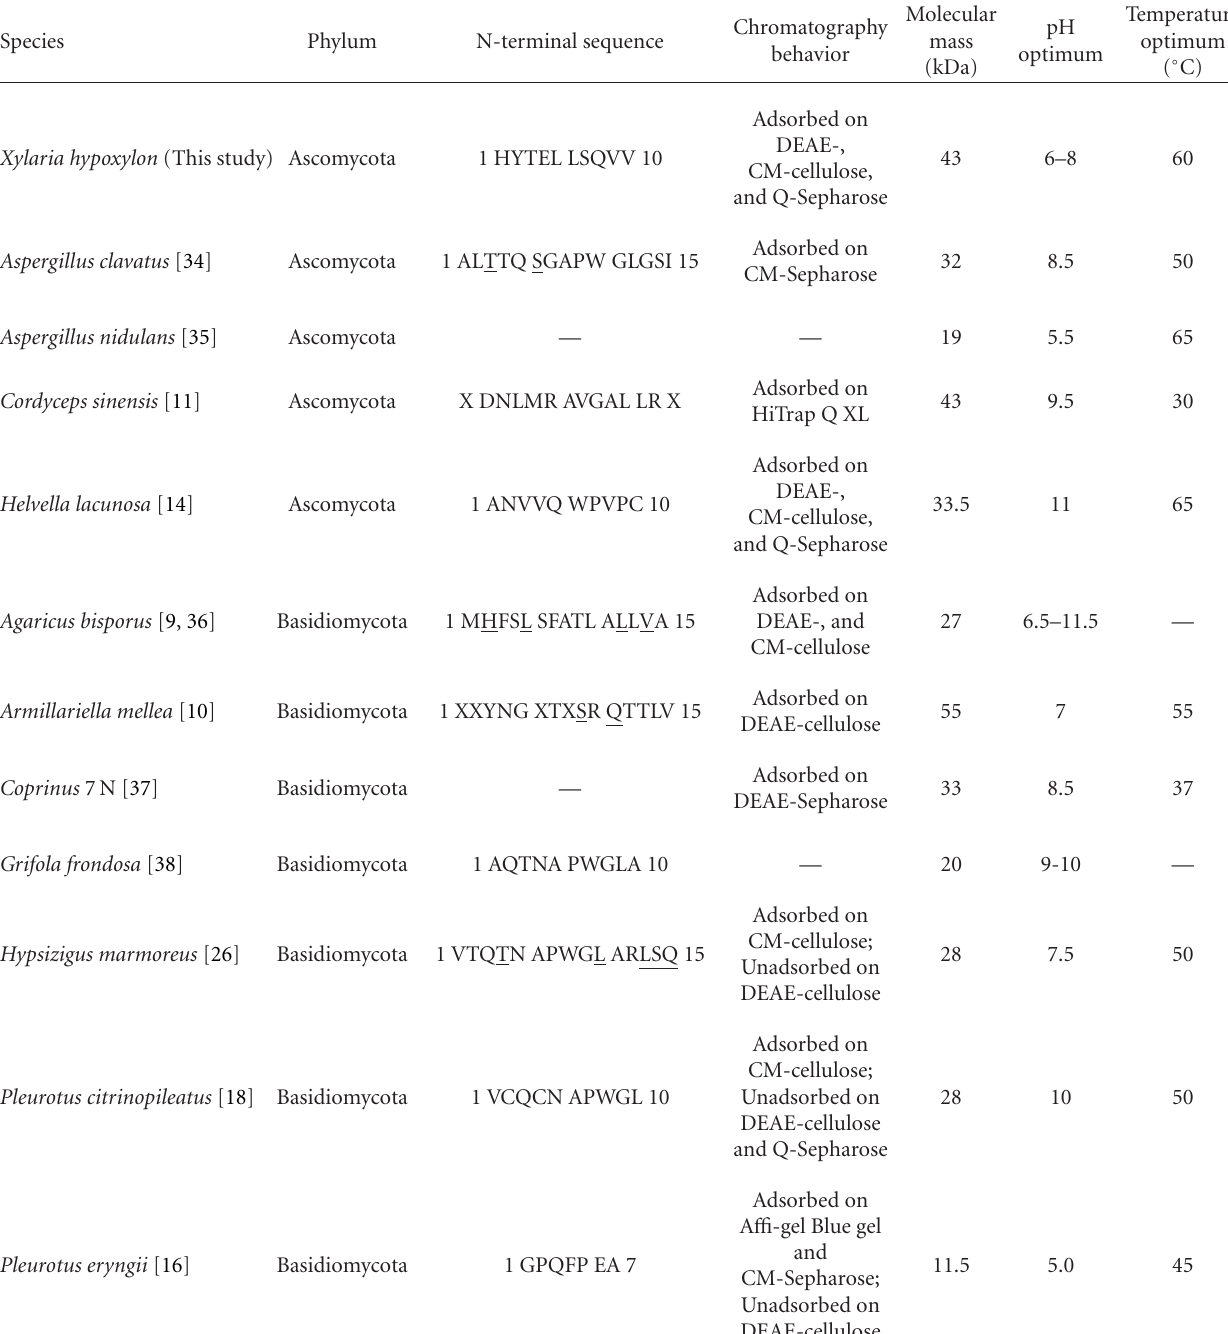
Table 2: Comparion of characteristics of Xylaria hypoxylon protease with other fungal